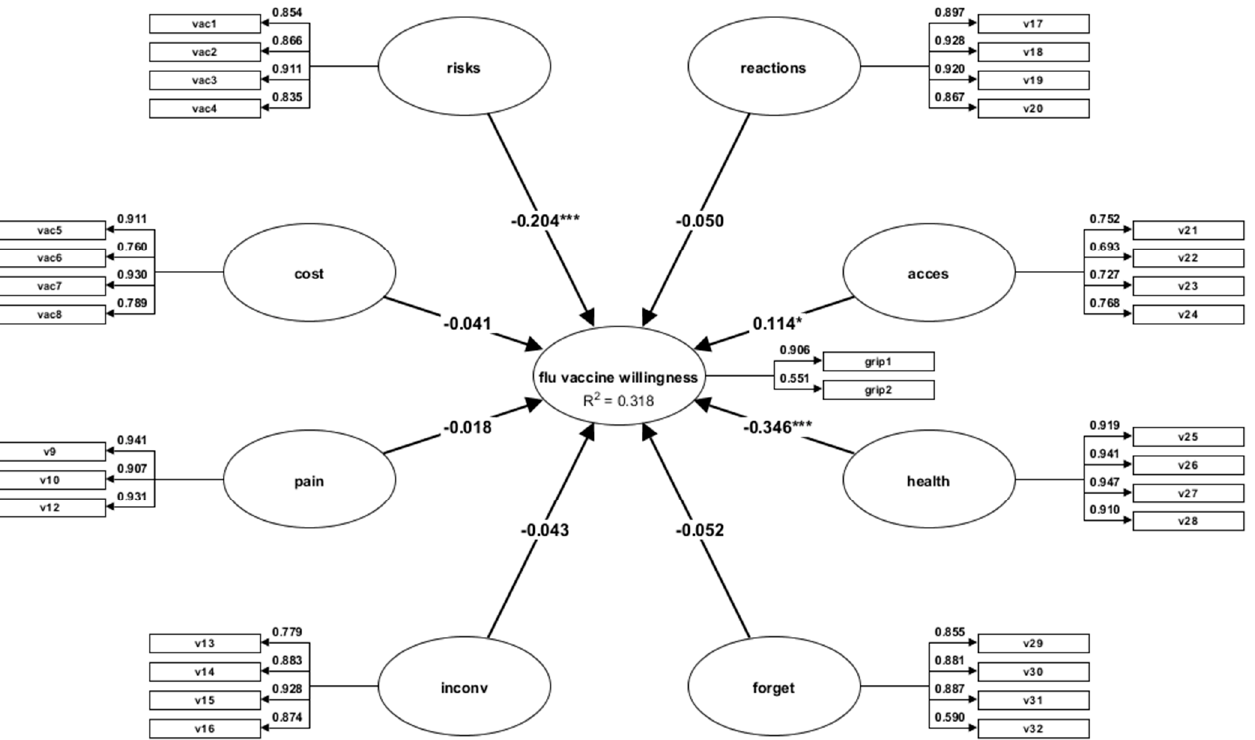
Figure 2. Variance-based structural equation modelling representing the MVHS prediction over flu vaccine willingness; note: The figure shows the path ( β ) coefficients, which highlight the links between the structural model variables; v1 − v32 = MVHS items. * p < 0.05; *** p < 0.001.